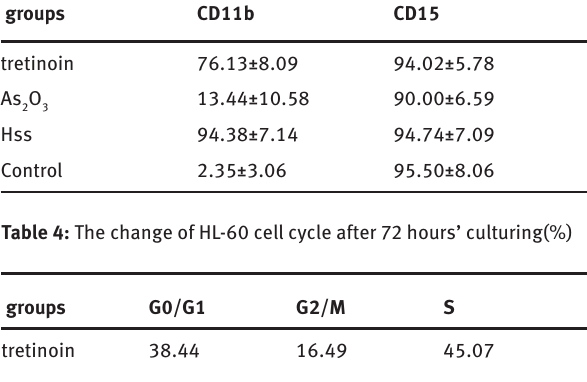
Figure 1: The morphological change(×1000) of cell under light microscope after 72 hours’ culture. A: Hss; B: tretinoin; C: AS